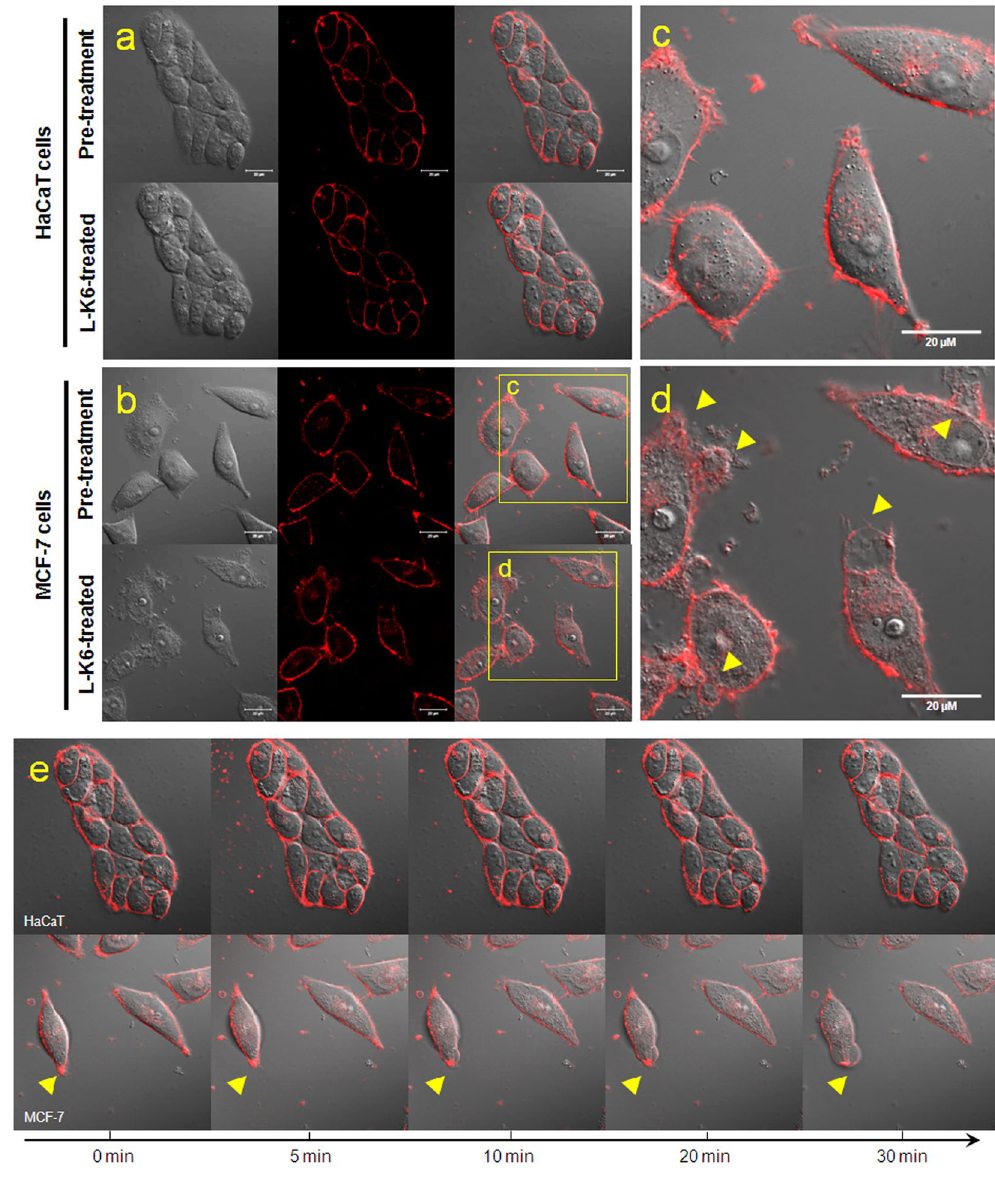
Figure 3. Morphological changes of the HaCaT or MCF-7 cell membranes after L-K6 treatment. The HaCaT ( a ) or MCF-7 ( b ) cells were cultured and treated with 50 μ M L-K6 for 30 min. The membrane fluorescence image indicated that while the HaCaT cell membrane showed no significant morphological changes following 30 min of L-K6 exposure, dramatic morphological changes were observed in the MCF-7 cell membrane, as indicated by cytoplasmic membrane perturbations and blebbing [yellow arrowheads; ( c ) pre-treatment; ( d ) post-treatment]. In addition, the dynamic tracing indicated that these morphological changes occurred as early as 10 min after L-K6 exposure ( e